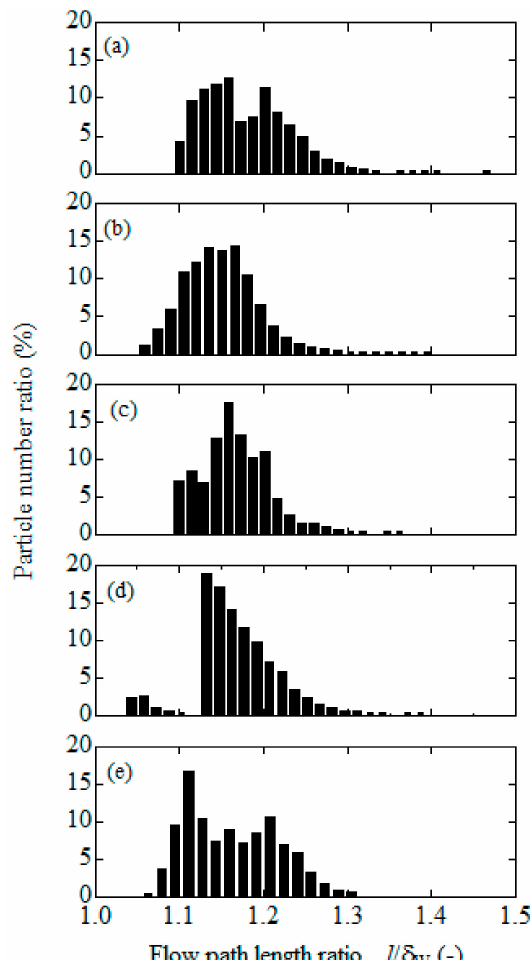
Figure 10. Particle number ratio of different flow path length ratios for five filters; ( a ) No. 1, ( b ) No. 2, ( c ) No. 3, ( d ) No. 4, ( e ) No.